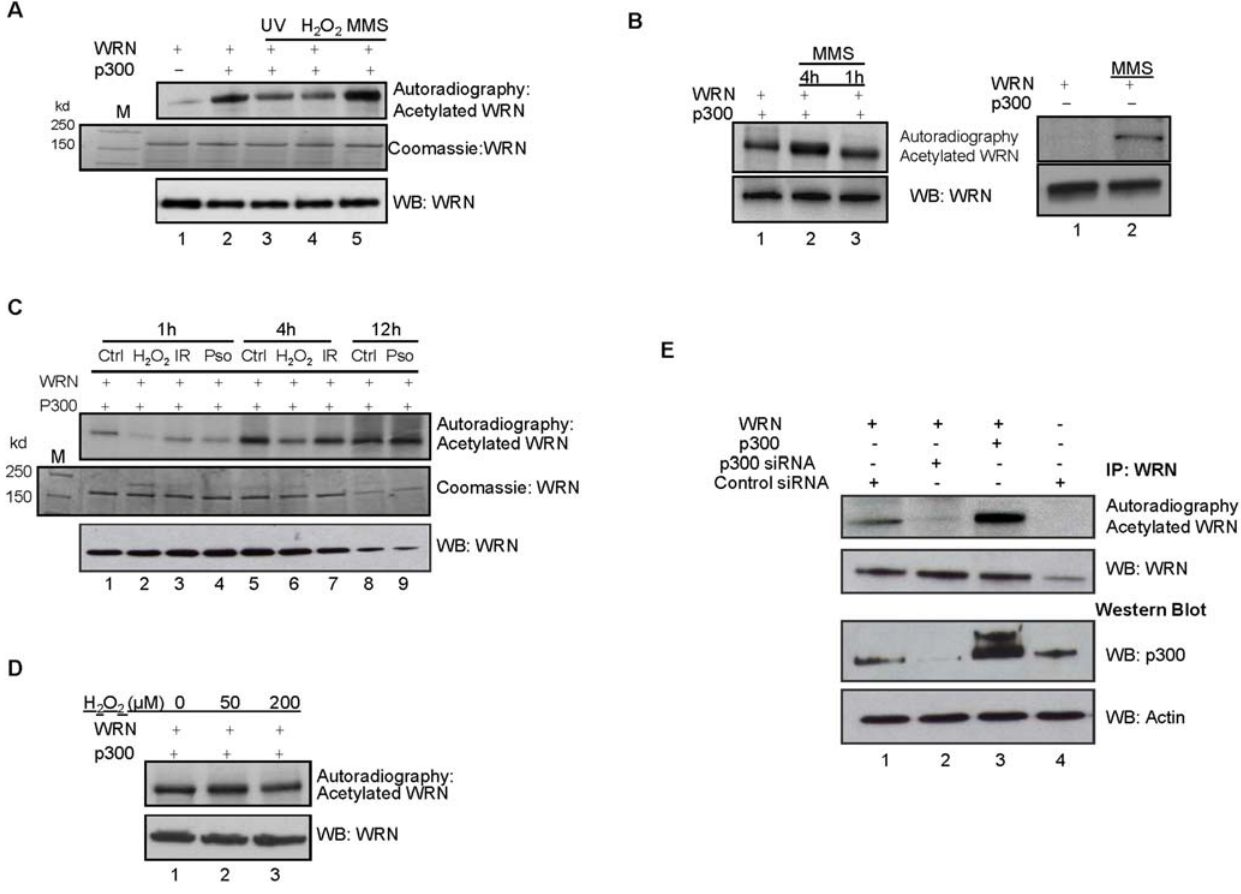
Figure 1. WRN is acetylated invivo and it is stimulated by MMS treatment. (A) WRN was transiently overexpressed in 293T cells either alone or together with p300. 48 h after transfection, untreated, UV, H 2 O 2 or MMS treated cells were labeled with 1 mCi/ml [ 3 H]sodium acetate for 1 h. [ 3 H]acetate labeled WRN was immunoprecipitated using an anti-WRN antibody and the complex was resolved on SDS-PAGE and was analyzed either by autoradiography (upper panel) or Western analysis (lower panel) or coomassie-stained gel after the acetylation assay, which was subsequently, analyzed using autoradiography (middle panel). (B) Right and left top panels: 48 h after transfection, the cells were treated with 1 mM MMS and WRN acetylation was followed for 1 h and 4 h (left panel) or 1 h (right panel), and labeled with 0.5 mCi/ml [ 3 H]sodium acetate for 1 h. [ 3 H]acetate labeled WRN was immunoprecipitated using an anti-WRN antibody and the complex was resolved on SDS-PAGE and analyzed by autoradiography. Lower panels: Western analysis of acetylated samples with an anti-WRN antibody. (C) Top panel: 48 h after transfection, the cells were treated with H 2 O 2 (1 and 4 h), c -irradiation (1 and 4 h) or psoralen + UVA (1 and 16 h) and labeled with 0.5 mCi/ml [ 3 H]sodium acetate for 1 h. [ 3 H]acetate labeled WRN was immunoprecipitated using an anti-WRN antibody and the complex was resolved on SDS-PAGE and analyzed by autoradiography. Medium panel: the coomassie staining of the gel before autoradiography. Lower panel: Western analysis of acetylated samples with an anti-WRN antibody. (D) Top panel: After transfection, the cells were treated with 50 m M and 200 m M H 2 O 2 and labeled with 0.5 mCi/ml [ 3 H]sodium acetate for 1 h. Lower panel: Western analysis of acetylated samples with an anti-WRN antibody. (E) 293T cells were transiently transfected with expression vectors of WRN (lanes 1–3), p300 (lane 3), siRNA of p300 (lane 2) or siRNA negative control (lanes 1 and 4) individually or in combination. [ 3 H]acetate labeled WRN was immunoprecipitated using an anti-WRN antibody and the complex was resolved on SDS-PAGE and was analyzed either by autoradiography (first panel) or Western analysis (second panel). Two bottom panels are Western analysis of these cell lysates with anti-p300 and anti- b -Actin antibodies, which shows relative protein expression levels.